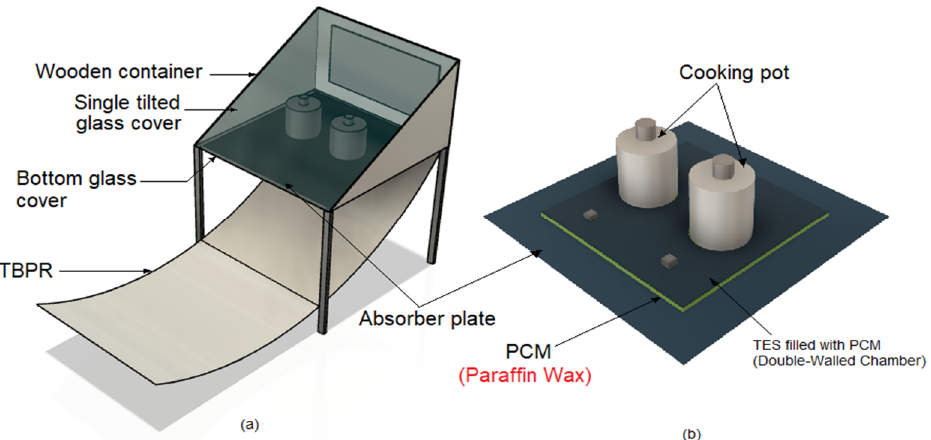
Figure 7. ( a ) Solar cooker with bottom parabolic reflector Tawfik et al., (2021) [99]. ( b ) Absorber plate incorporated with PCM Tawfik et al., (2022) [100]. Reprinted/adapted with